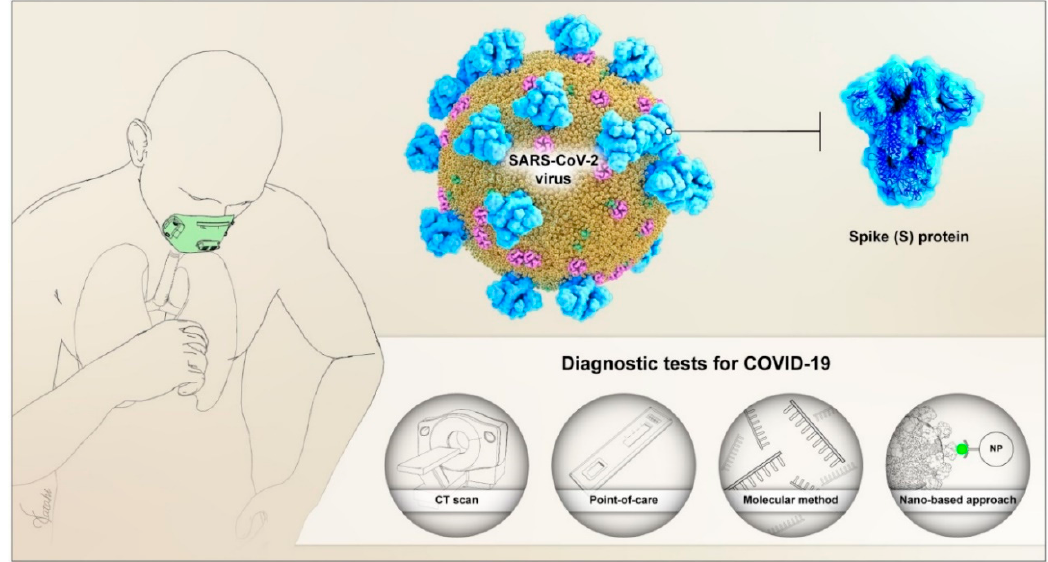
Figure 1. Schematic illustration of common Lung computed tomography (CT) and molecular test for diagnosis of severe acute respiratory syndrome coronavirus 2 (SARS-CoV-2), and emerging detection methods, based on the optical-based biosensor, Point-of-Care (POC) testing, and the optical-based nanosensor.